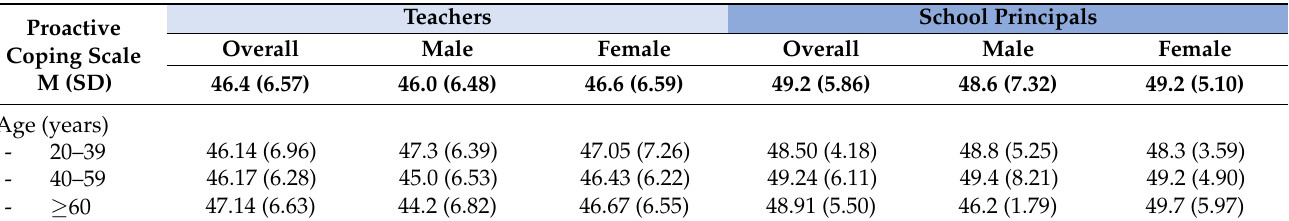
Table 4. Results Proactive Coping